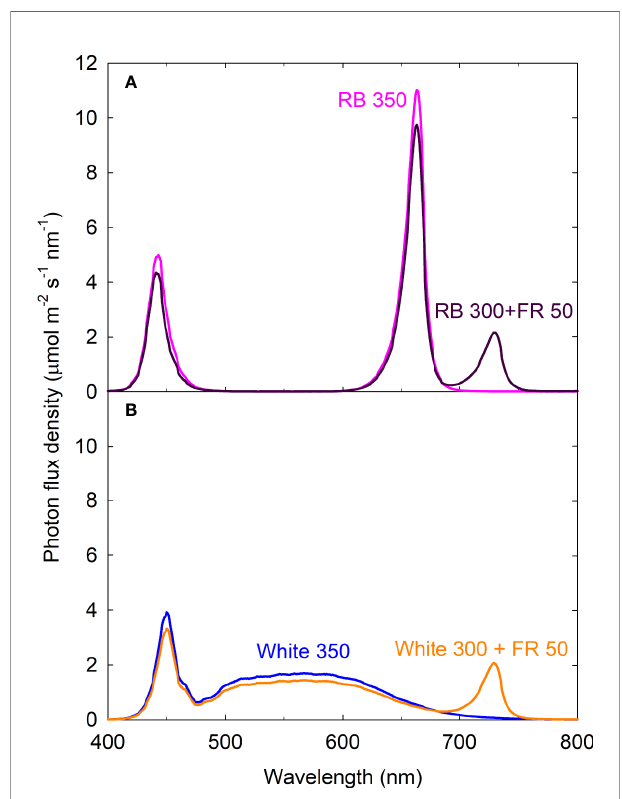
FIGURE 1 | Spectral distributions of four light treatments composed of red/ blue (RB; peaks at 443 and 663 nm), white (peak at 450 nm with secondary peak at 567 nm), and far-red (FR; peak at 730 nm) photons. The numbers following each type of light ( e.g. RB 350) indicate photon fl ux density in m mol m − 2 s − 1 . All four treatments had equal total photon fl ux of 350 m mol m − 2 s − 1 (400 to 750 nm) and 31.5% blue